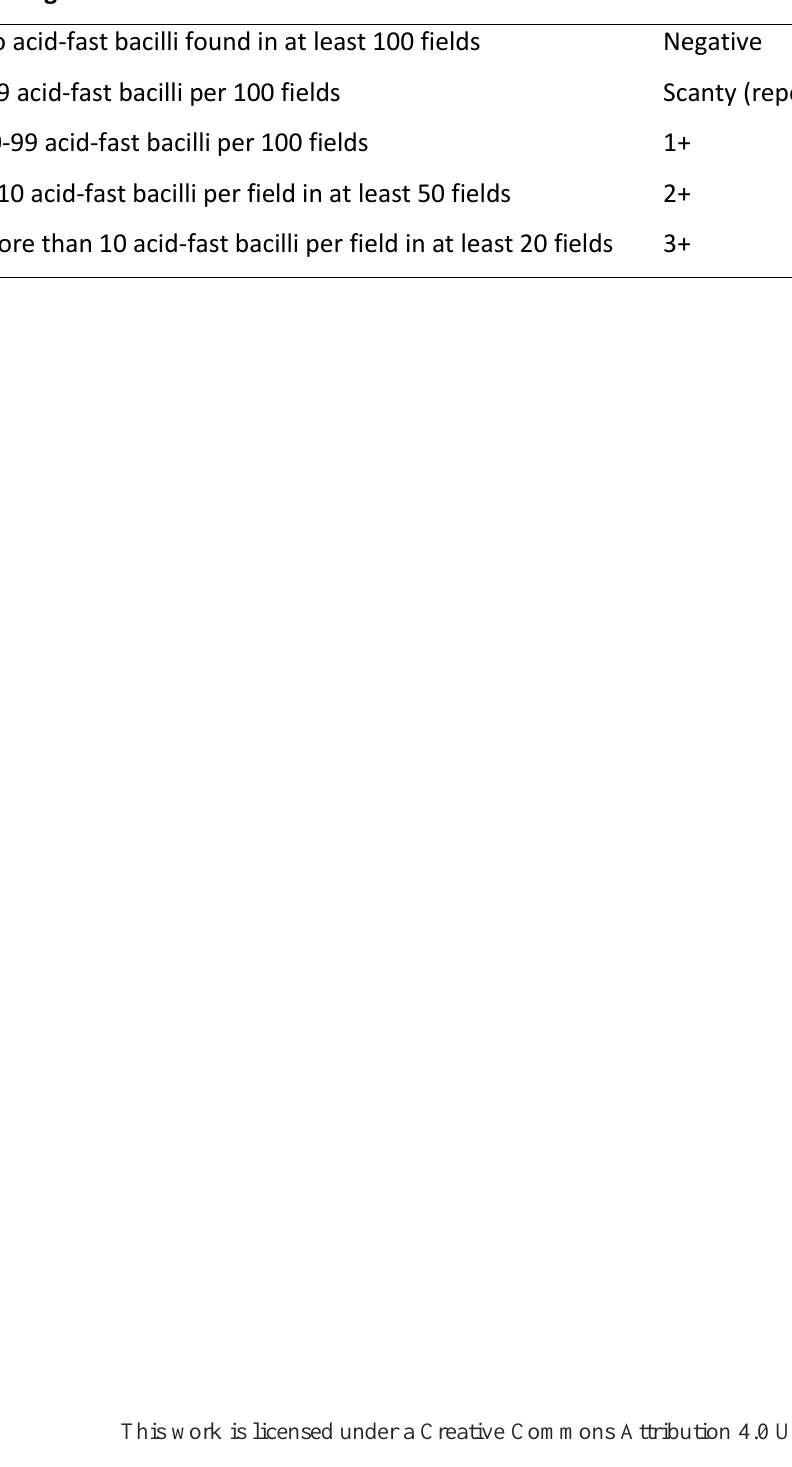
Table S1: AFB Smear Microscopy Grading system